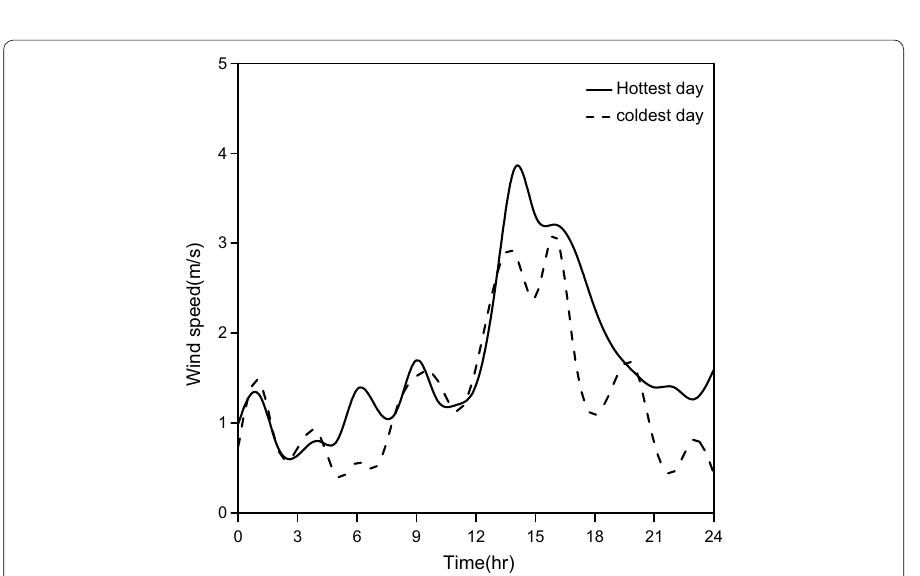
Fig. 4 Wind speed for the hottest day (21st April) and the coldest day (24th January), 2016 in